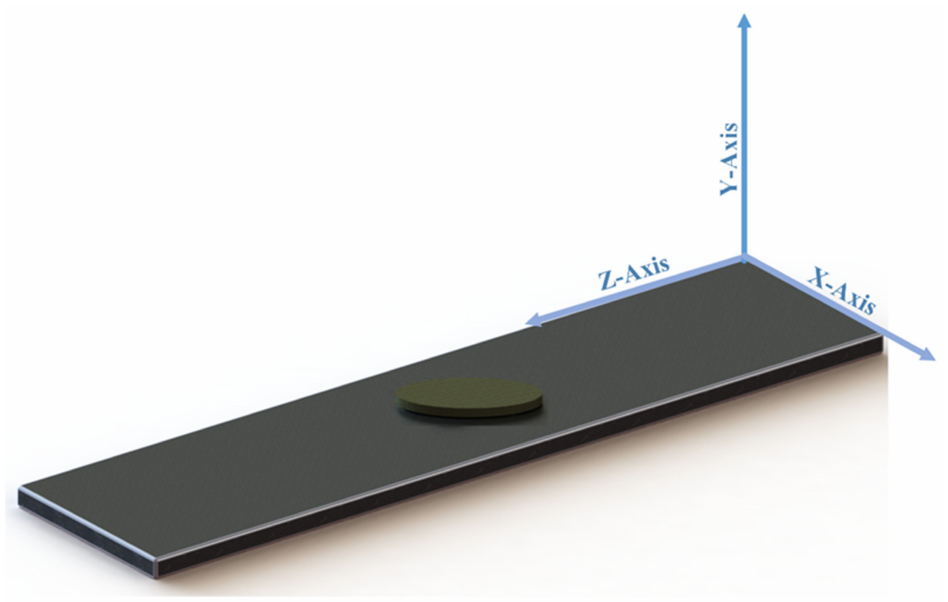
Figure 2. FE model of cracked aluminum plate repaired by composite patches.